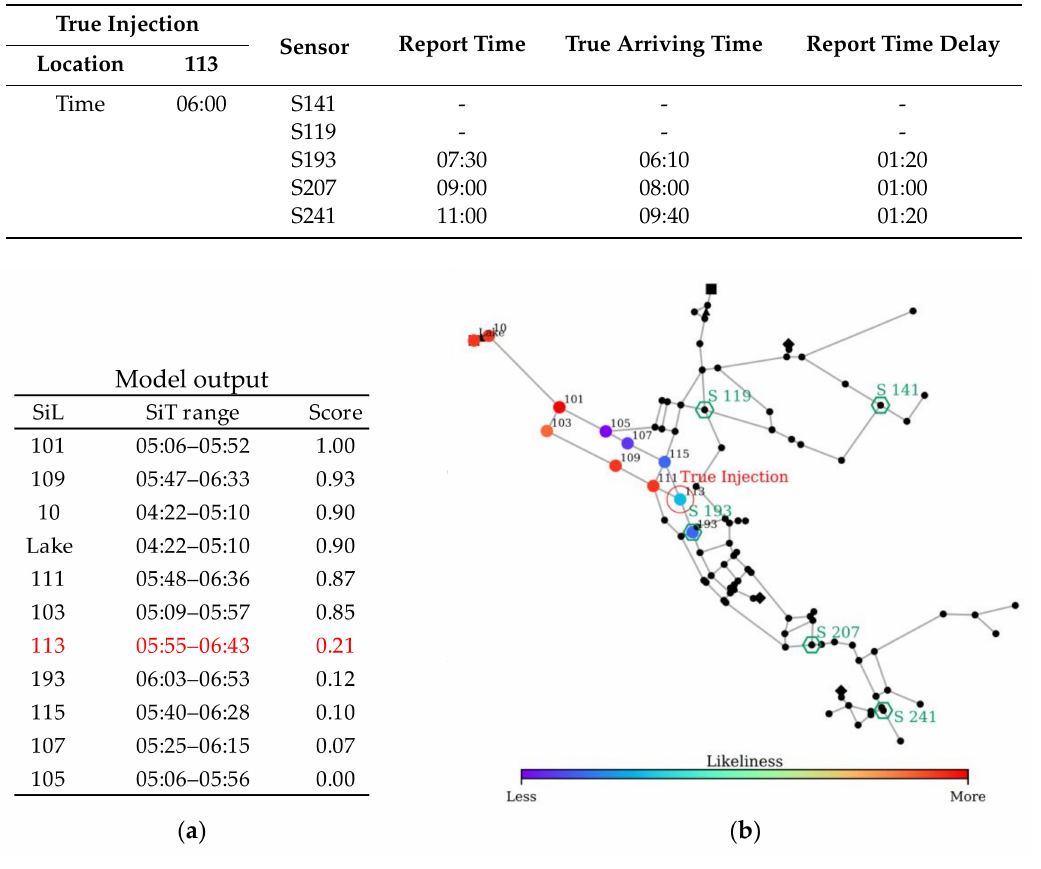
Table 9. True injection and sensor information (scenario 3).